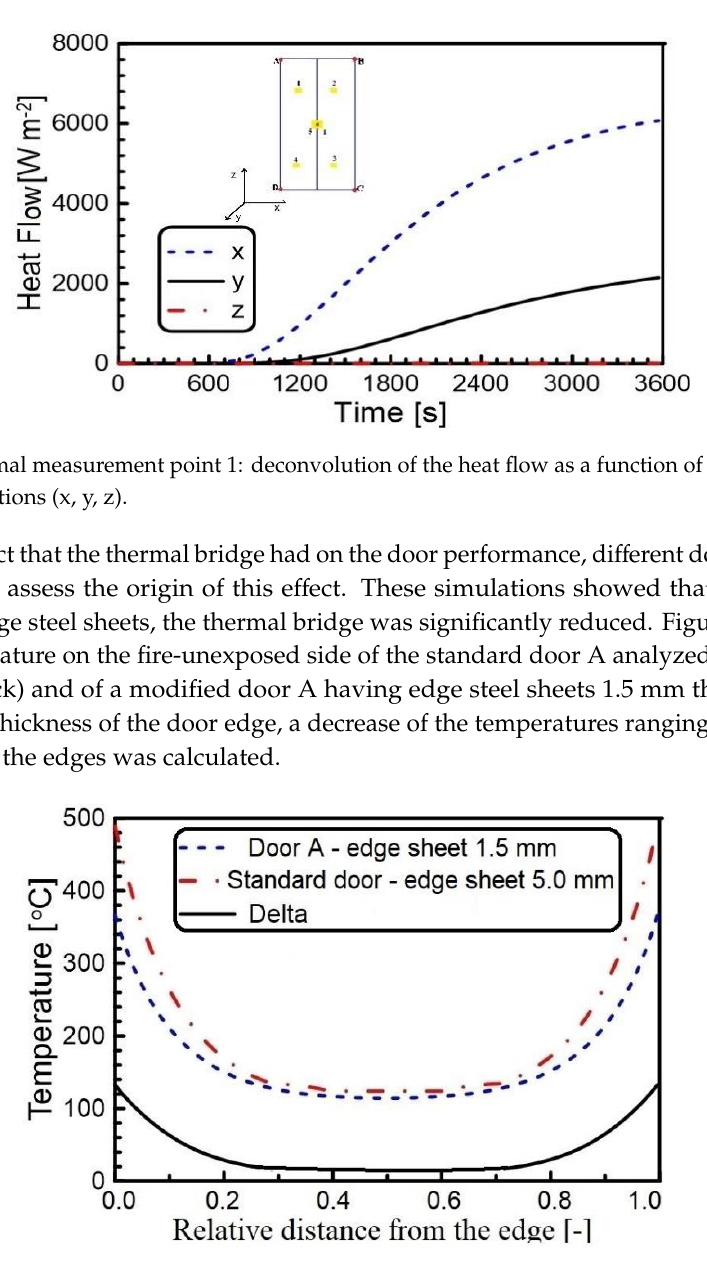
Figure 7. Transversal temperature profiles calculated at the final stage of the fire test (60 min) using unsteady-state FEM model: comparison of the standard and modified doors. Delta: temperature di ff erence between the standard and modified doors.